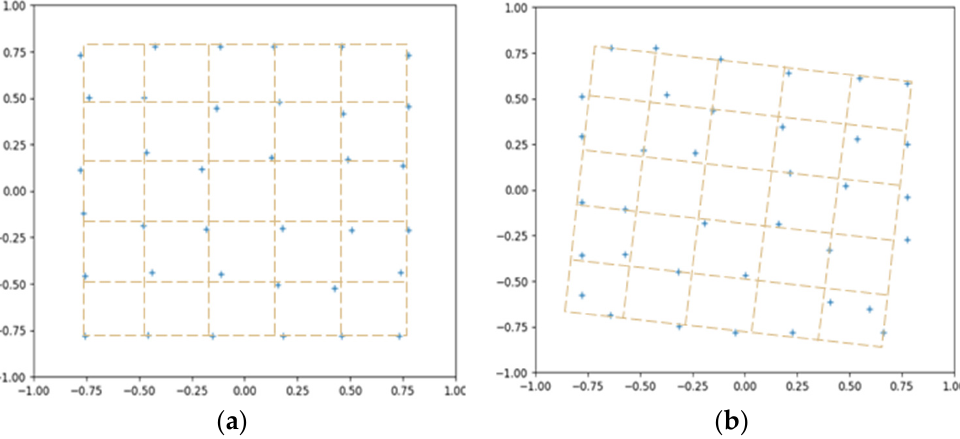
Figure 10. The example of distribution of sub-images in the original images ( 𝑛 𝑠 = 3 6), where “+” represents the centers of sub-images. ( a ) is the source image, ( b ) is the target image. The coordinates are normalized to [ − 1, 1], which shows that the distribution is not strictly grid aligned.